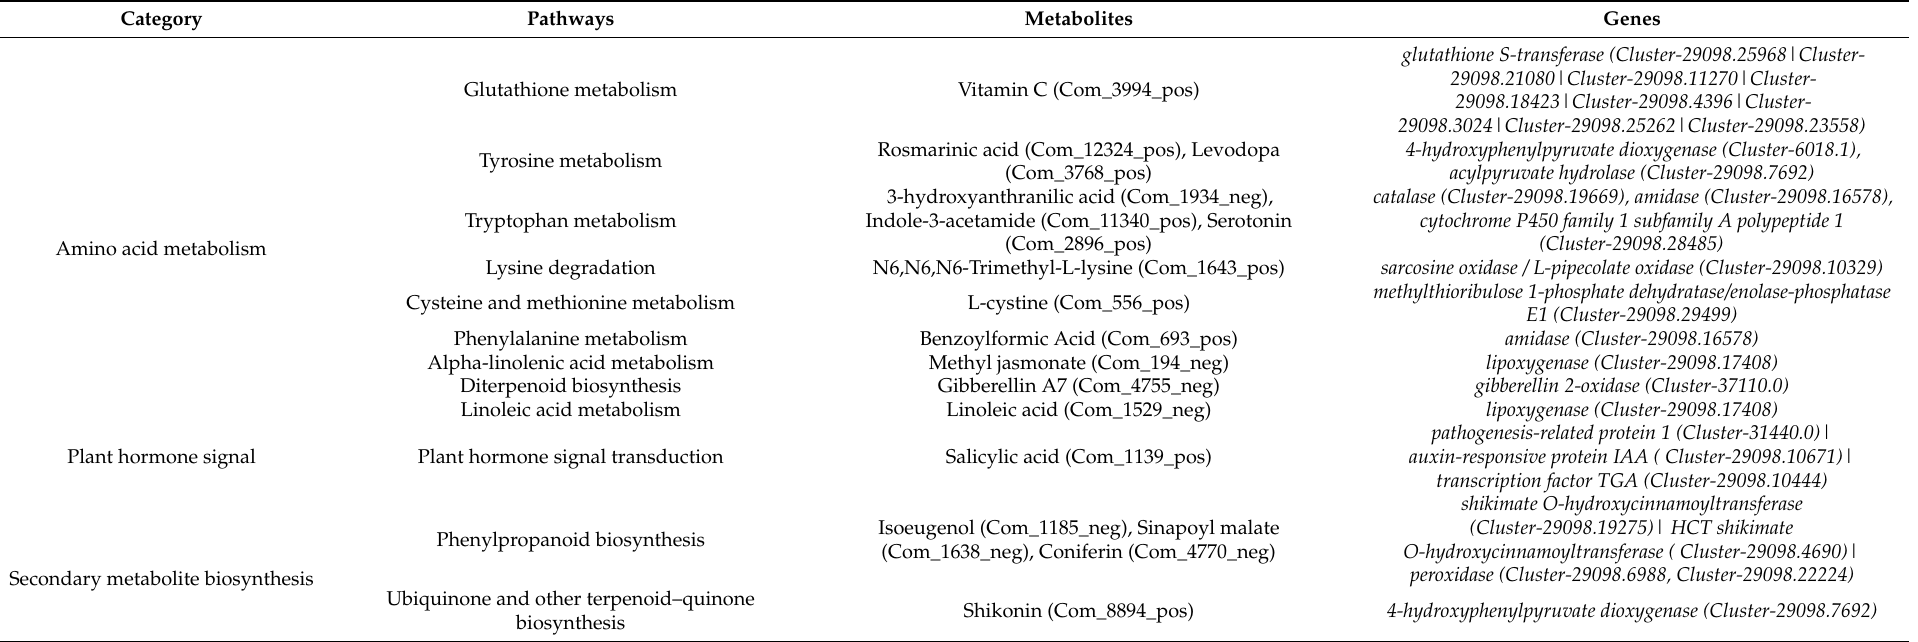
Table 1. Genes and their corresponding interacting metabolites involved in sugarcane defense against S. frugiperda